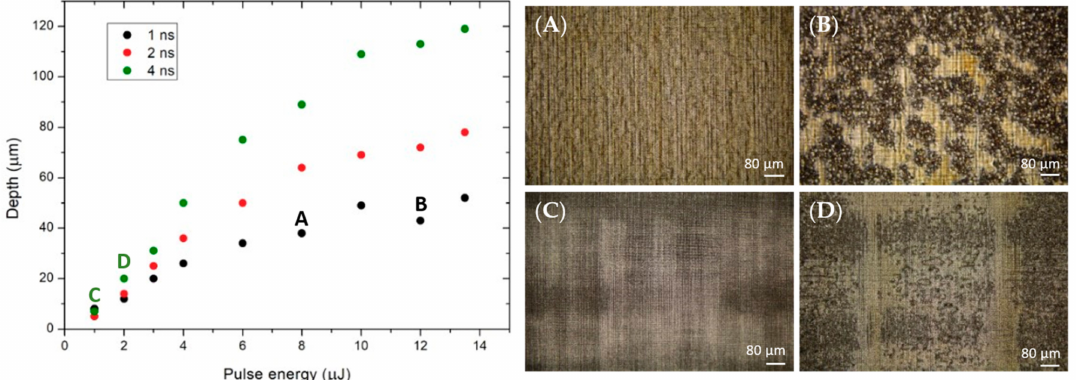
Figure 5. Structure depth evolution graph as a function of the laser pulse energy for three different pulse durations used in the experiment. Panels ( A – D ) show bottom morphology for four different parameter combinations, indicated on the graph (A: 1 ns, 8 µ J; B: 1 ns, 12 µ J; C: 4 ns, 1 µ J; D: 4 ns, 2 µ J). Scale bars are all equal to 80 µ m.